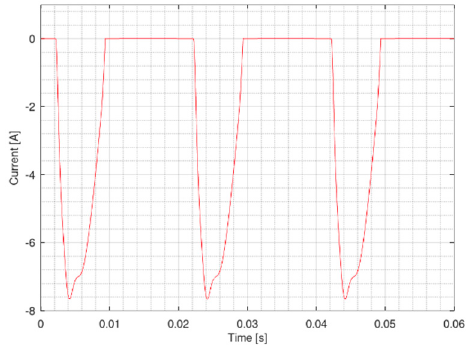
Figure 14. Current through the nonlinear element in the time domain (Illustrative Example 2).